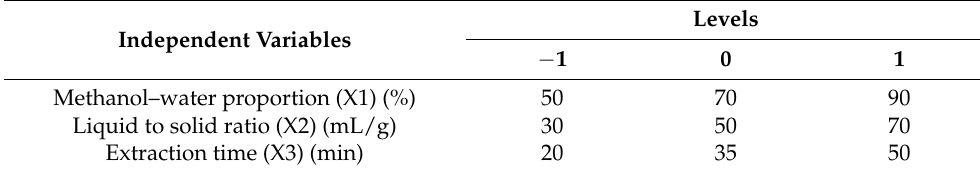
Table 5. The level of independent variables for Box-Behnken design. Independent